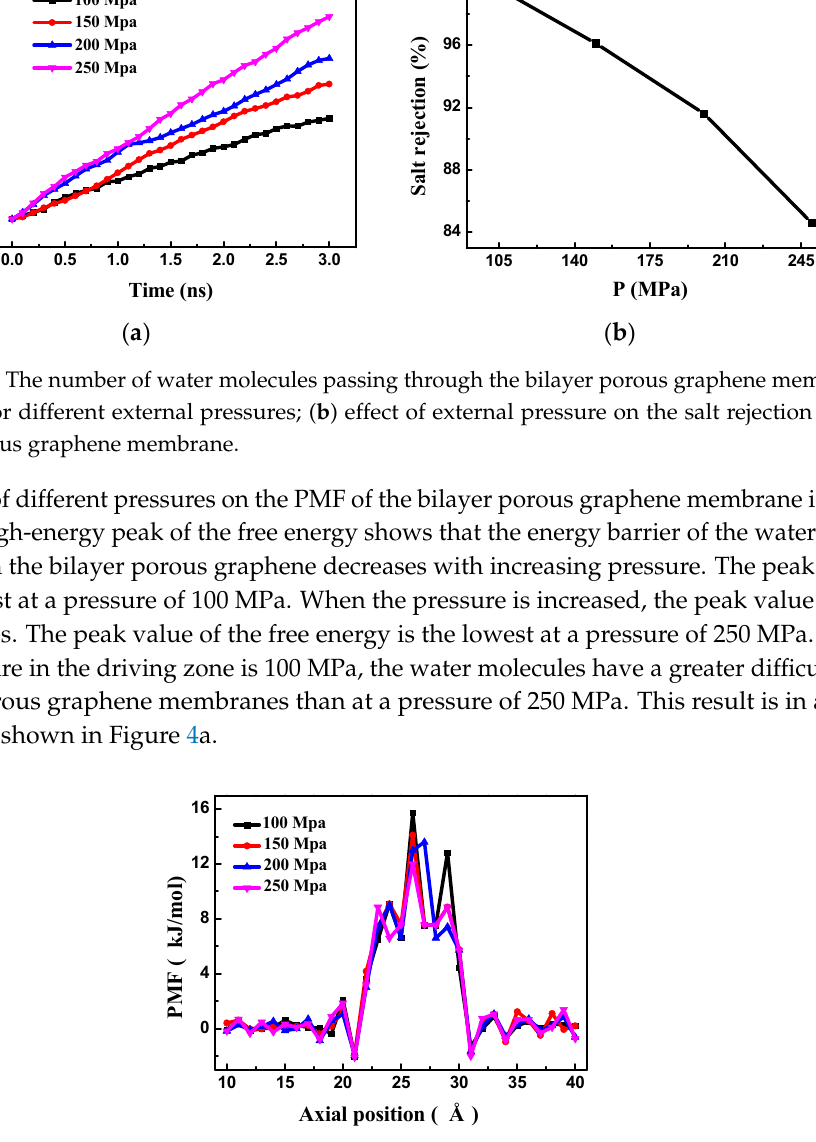
Figure 5. The PMF of the bilayer porous graphene membrane as a function of external pressure. The different layer separation distances of the bilayer porous graphene membrane h are 3.4 Å, 5.0 Å, 6.5 Å, and 8 Å; these values are lower than the cutoff radius. The effect of the pore offset on the membrane performance is investigated by changing the offset s of the graphene hole centers; the different offset values s are 0.0 Å, 2.5 Å, 5.0 Å, and 7.5 Å. A diagram of the layer separation and pore offset of the bilayer graphene membrane is shown in Figure 6a. The salt solution concentration (70.2 g/L) and the driving zone pressure are constant at 200 MPa during the simulated RO process. The number of water molecules passing through the bilayer porous graphene membrane over time for different layer separation distances is shown in Figure 6b. The number of water molecules passing through the membrane increases almost linearly over time. When the layer separation h is 3.4 Å